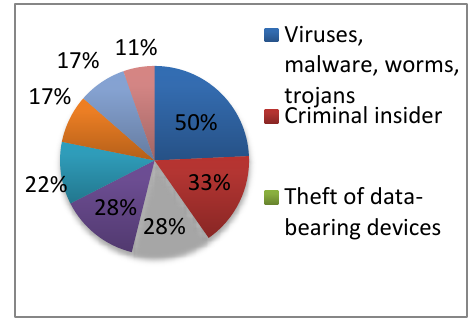
Figure 4. Cyber-Attack